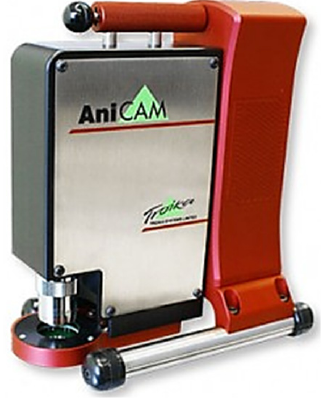
Figure 3. Troika AniCAM optical microscope.